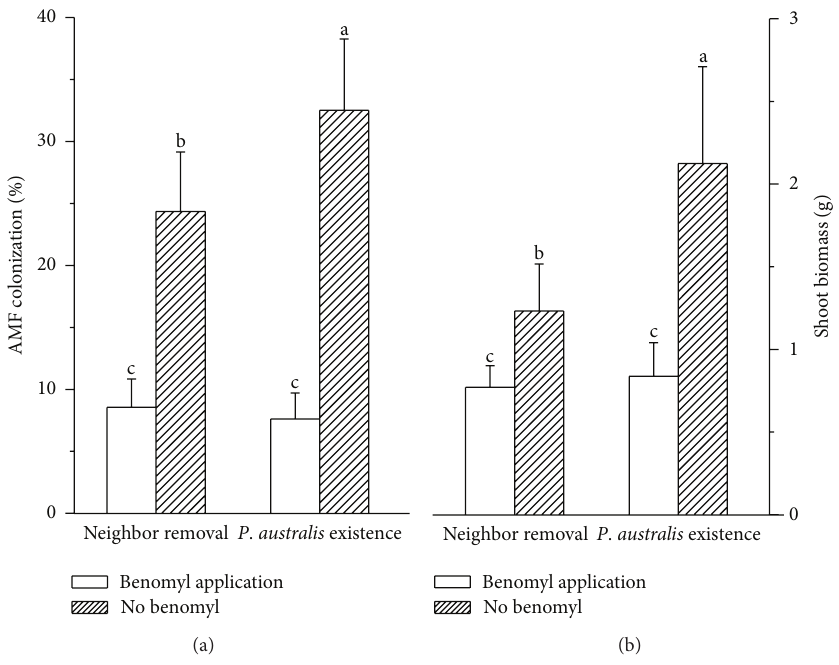
Figure 5: Effect of P. australis removal and benomyl application on AMF colonization of I. polycephala (a) and shoot biomass (b). Different letters represent significant difference among